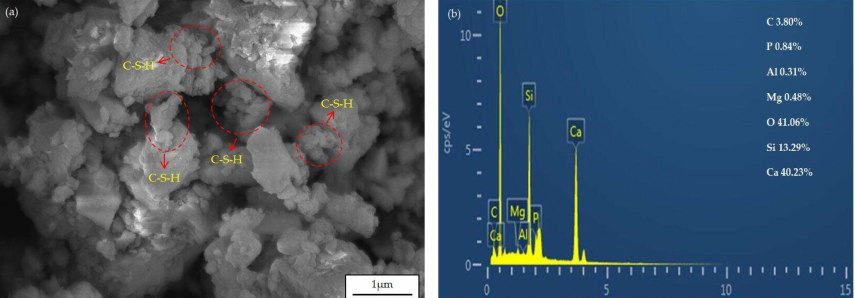
Figure 3. The micrograph and EDS spectra of LCFS: ( a ) The micrograph of LCFS; ( b ) The EDS of C 2 S on ( a